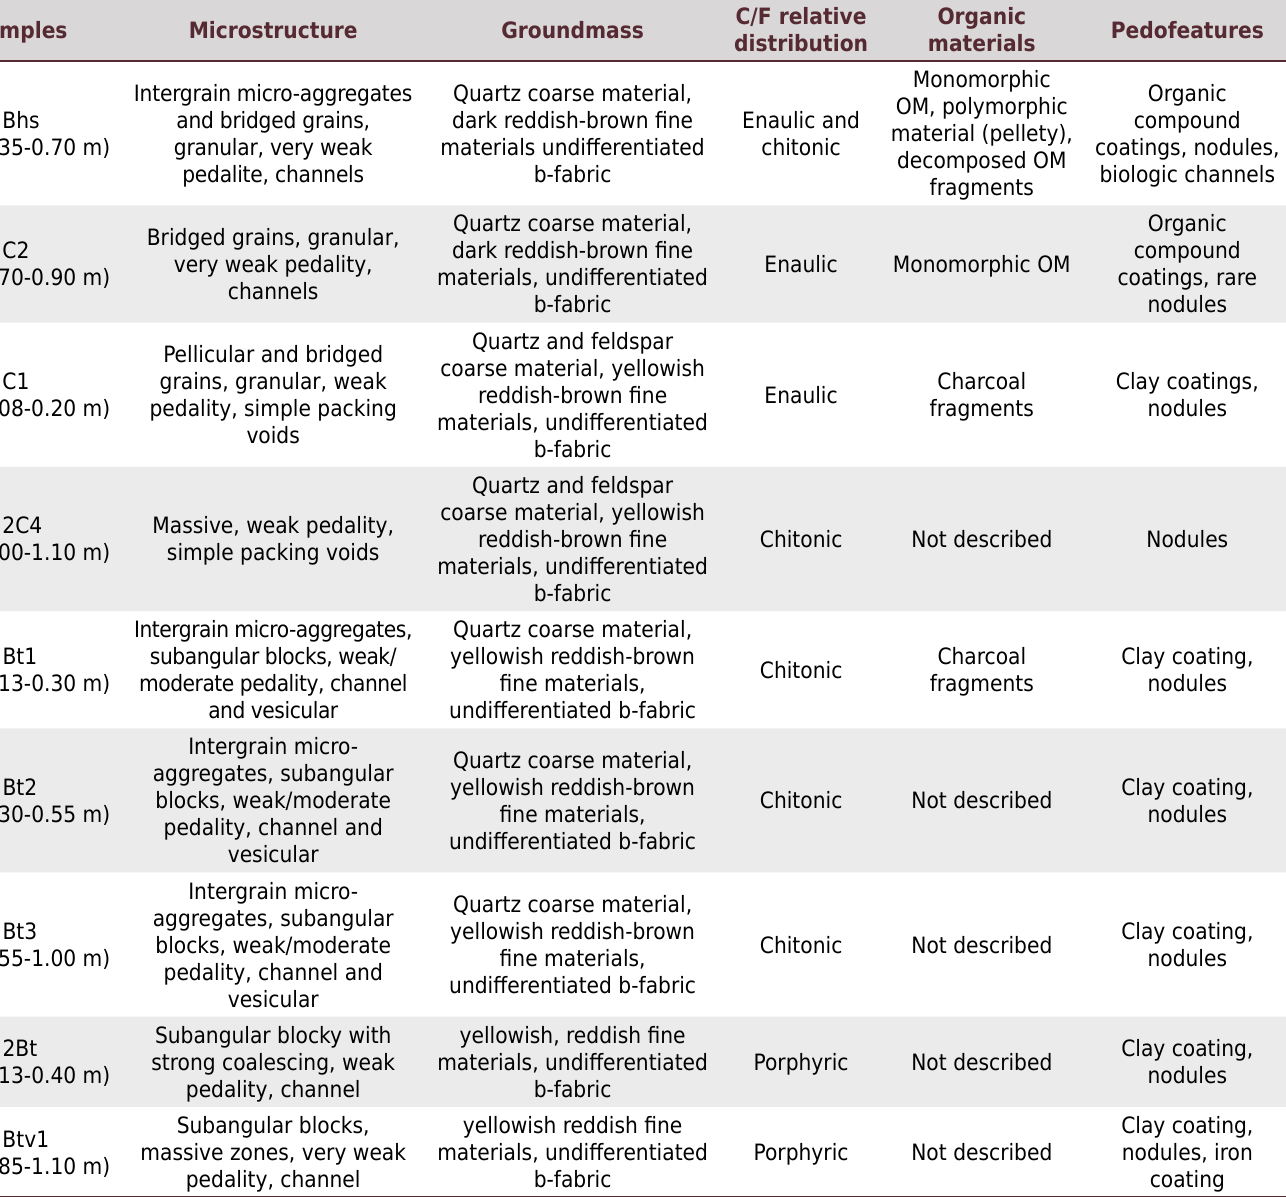
Table 7. Synthesis of the micropedology characteristics of the studied soils